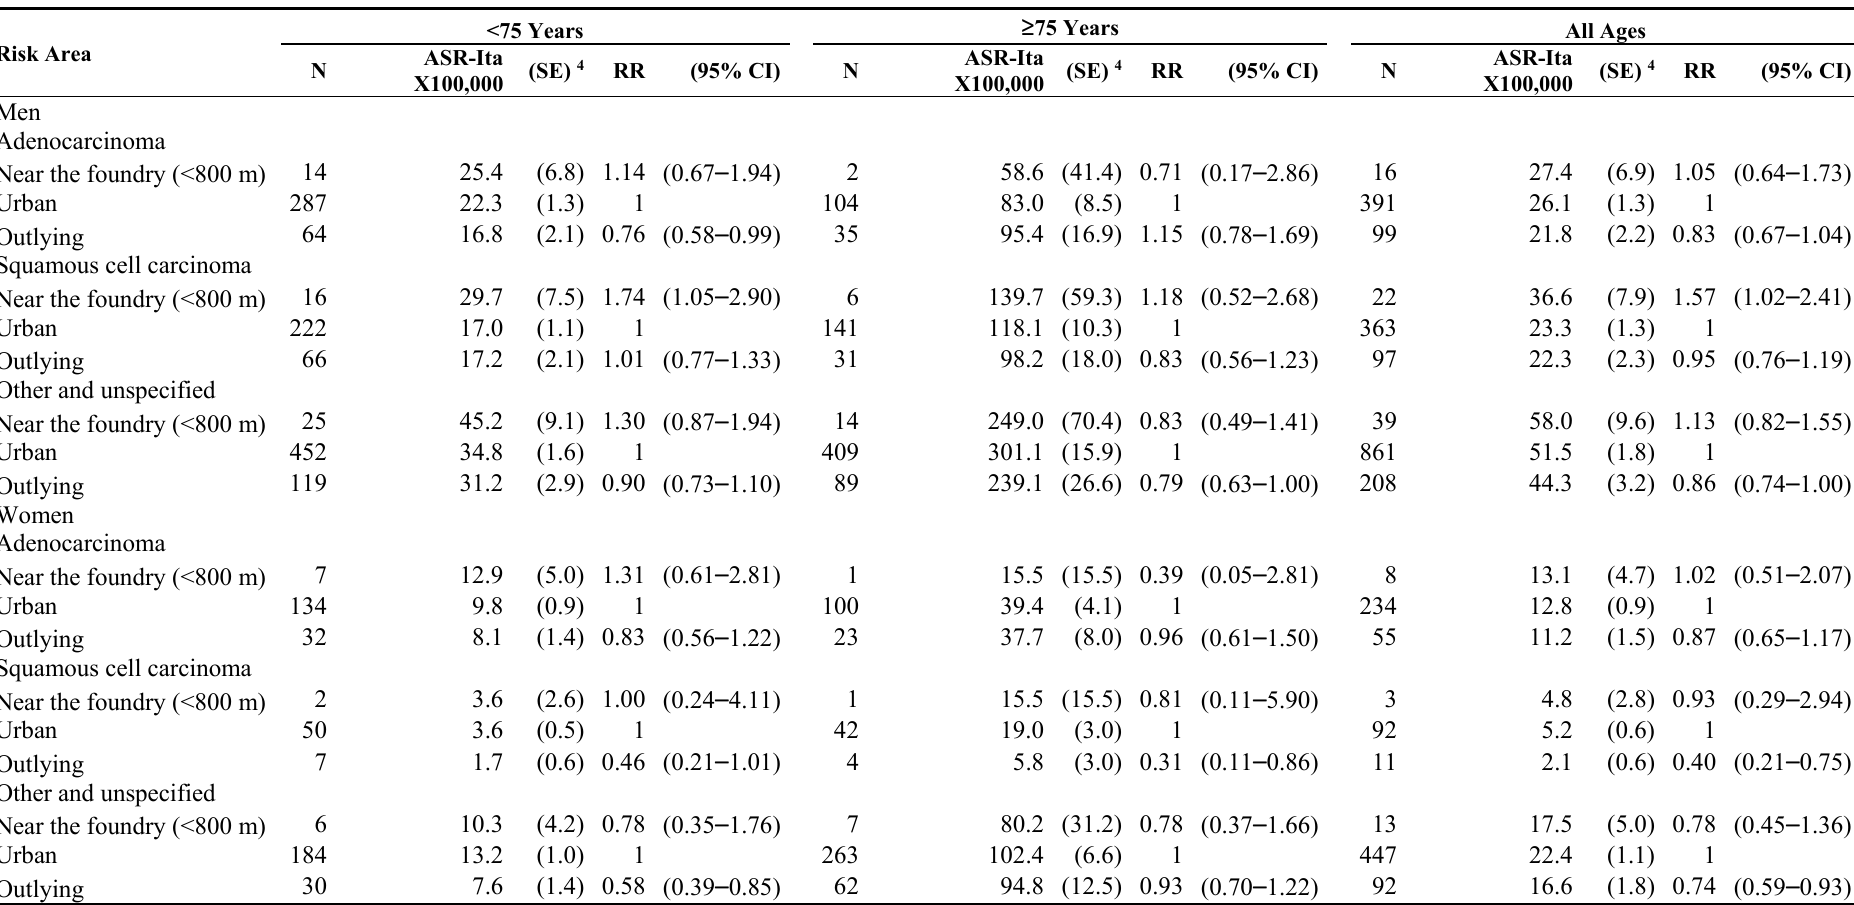
Table 2. Incident cases of lung cancer 1 , age-standardized rates on Italian population (ASR-Ita 2 ) and rate ratios (RR), with corresponding 95% confidence intervals (CI), by sex, morphology, and risk area according to age groups during the 1995–2009 in the municipality of Trieste 3